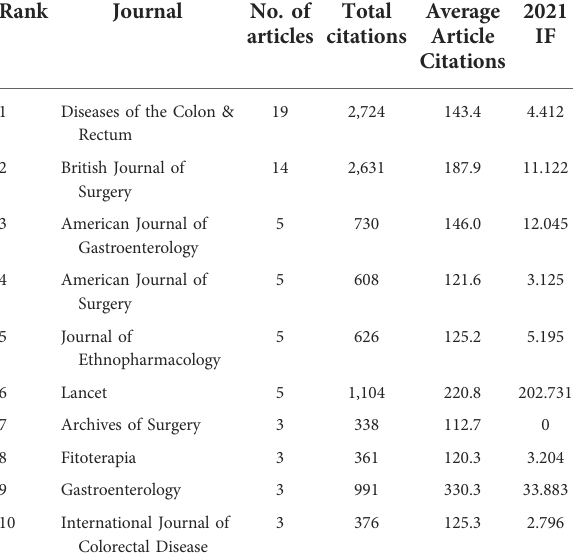
TABLE 5 The top 10 journals containing the most cited literature. Rank No. of